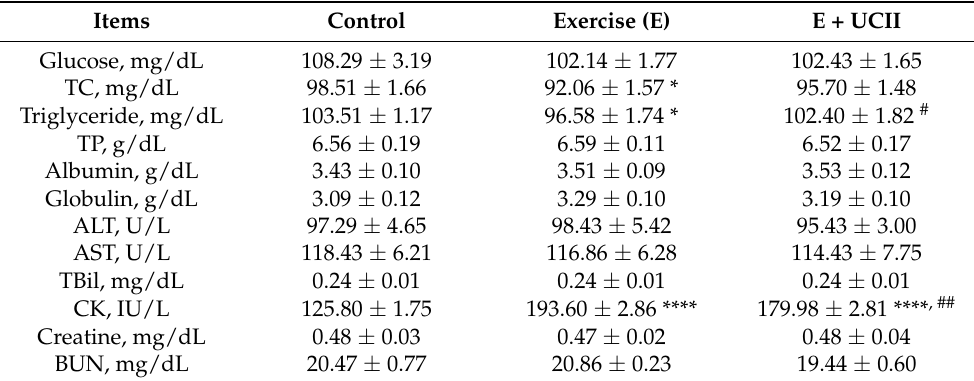
Figure 1. The effect of UCII on body weight ( A ) and exhaustion time ( B ) in exercised rats. Box and Whisker plots show median, min, and max values. ANOVA and Tukey’s post-hoc test were used to compare the results among different treatment groups. Statistical Scheme ** p < 0.01; **** p < 0.0001 compared to the control group and ## p < 0.01 compared to the exercise group. UCII, Undenatured type II collagen. Control (Circle): no exercise and no UCII, E (Square): exercised rats, E + UCII (triangle), exercised rats receiving 4 mg/kg BW/day UCII. Table 1. The effects of UCII on serum parameters in exercised rats ( n =